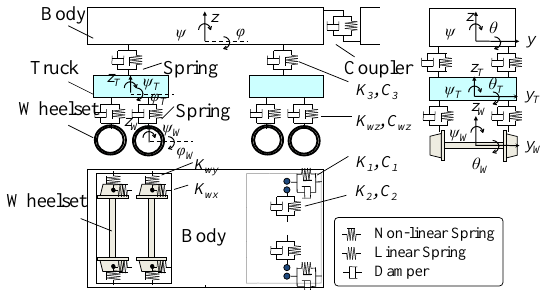
Figure 10. Dynamic model of the vehicle.